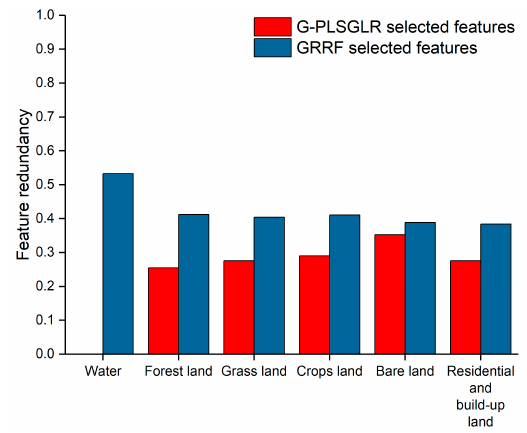
Figure 4. Feature redundancy of G-PLSGLR and GRRF against six land cover categories.